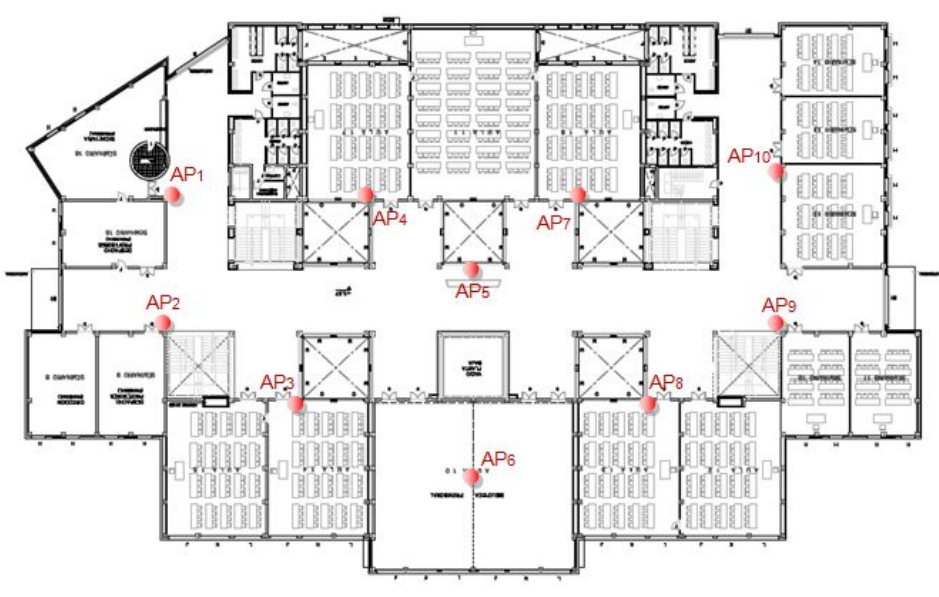
Figure 2. Test bench place used in the experiments.